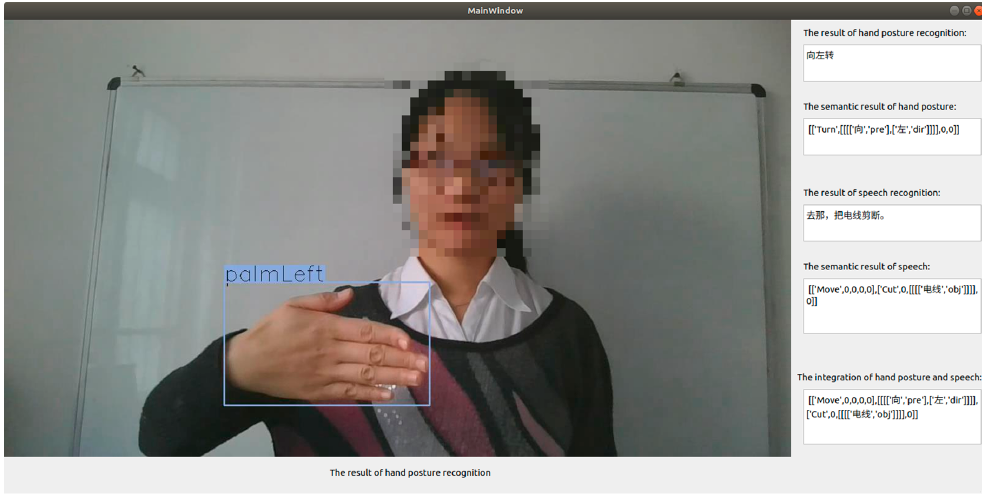
Figure 25. Results of the integration of deictic hand posture and voice commands.